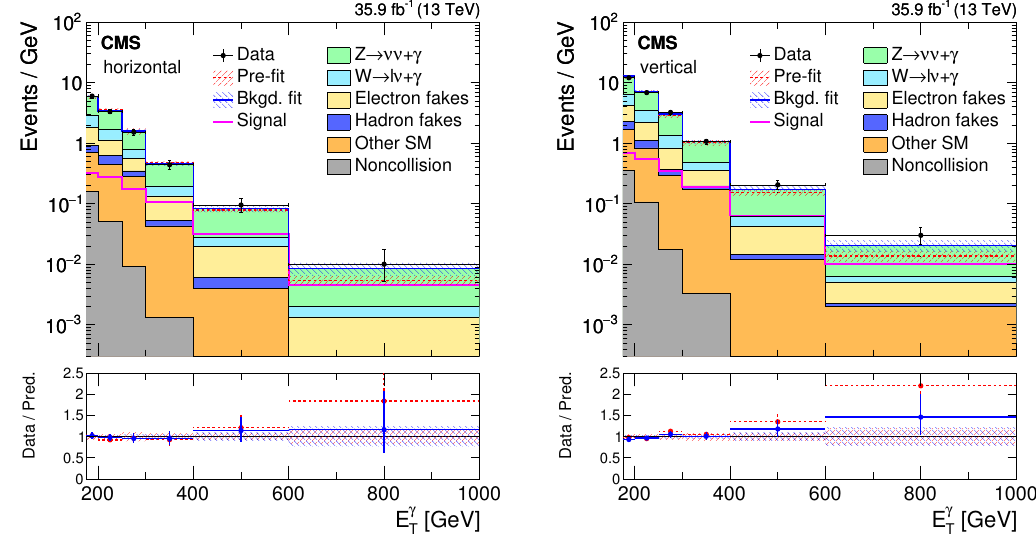
Figure 6 . Observed E (cid:13) distributions in the horizontal (left) and vertical (right) signal regions T compared with the post-(cid:12)t background expectations for various SM processes. The last bin of the distribution includes all events with E (cid:13) > 1000 GeV. The expected background distributions are T evaluated after performing a combined (cid:12)t to the data in all the control samples and the signal region. The ratios of data with the pre-(cid:12)t background prediction (red dashed) and post-(cid:12)t background prediction (blue solid) are shown in the lower panels. The bands in the lower panels show the post- (cid:12)t uncertainty after combining all the systematic uncertainties. The expected signal distribution from a 1 TeV vector mediator decaying to 1 GeV DM particles is